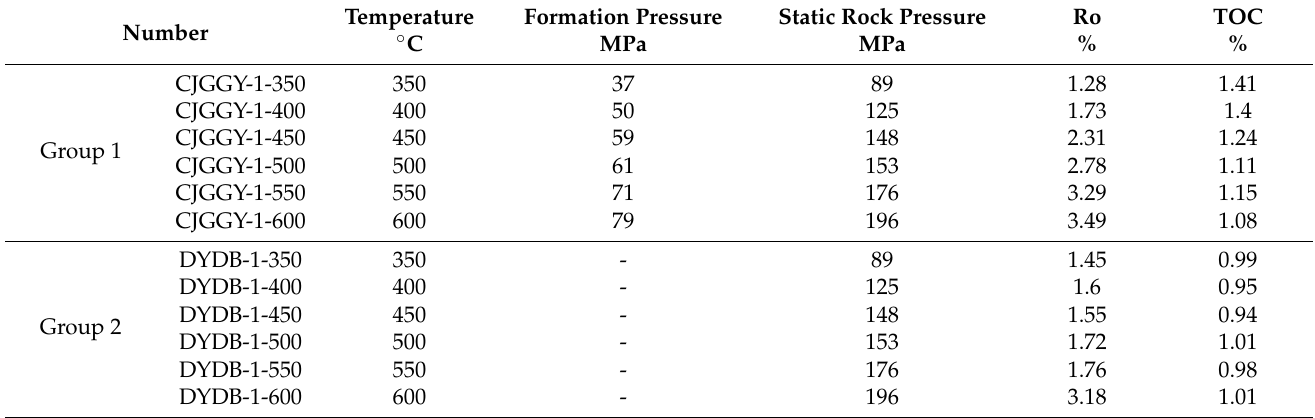
Table 2. Experimental temperature and pressure used for the pyrolysis simulation